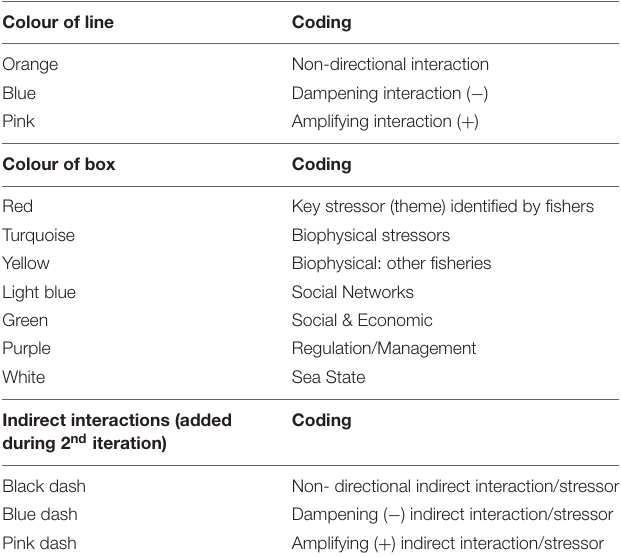
TABLE 1 | Colour coding for interaction between variables in the Causal mapping of stressors that drive change in the linefishery in the southern